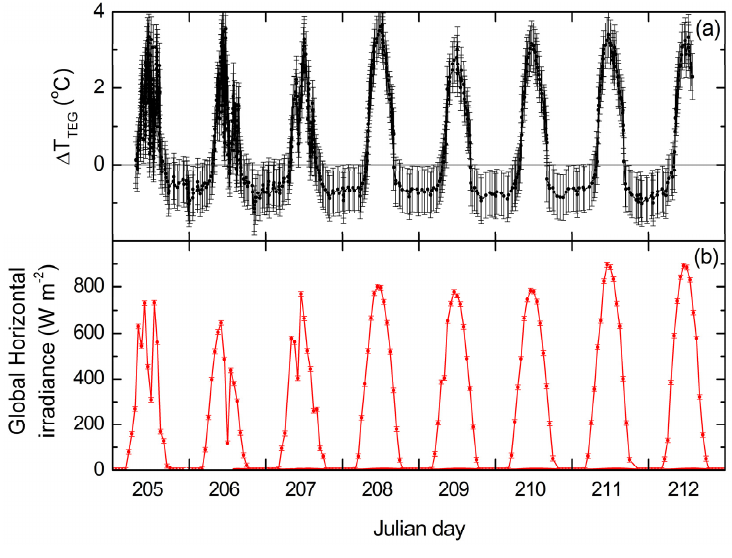
Figure 8. ( a ) Measured temperature differences at TEG faces. ( b ) Measured hourly global horizontal irradiance.